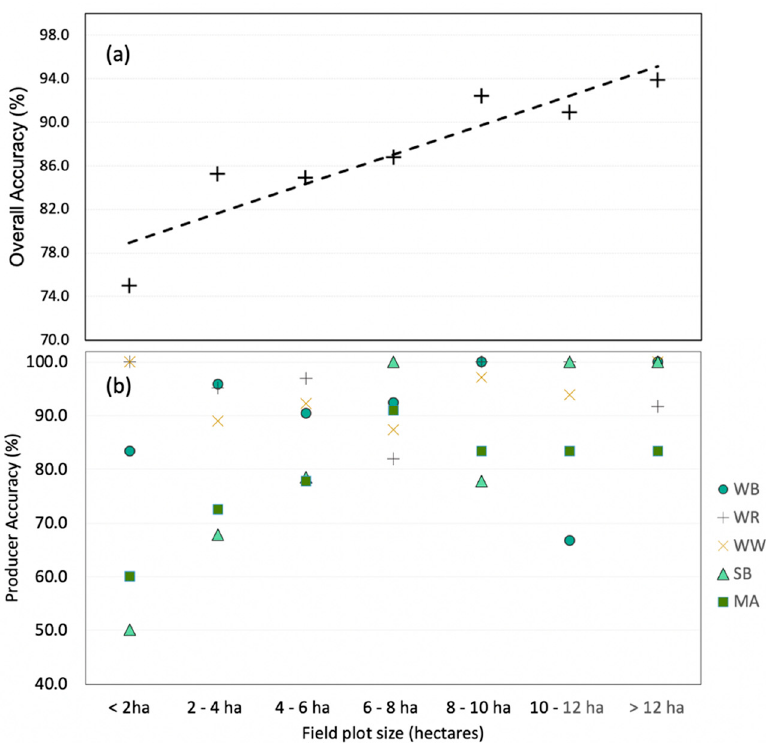
Figure 7. ( a ) Overall accuracy and ( b ) producer accuracies by field size for the new (K-based) map. These plots consider all the fields regardless of the region. WB = winter barley, WW = winter wheat, WR = winter rapeseed, SB = spring barley, MA = maize.